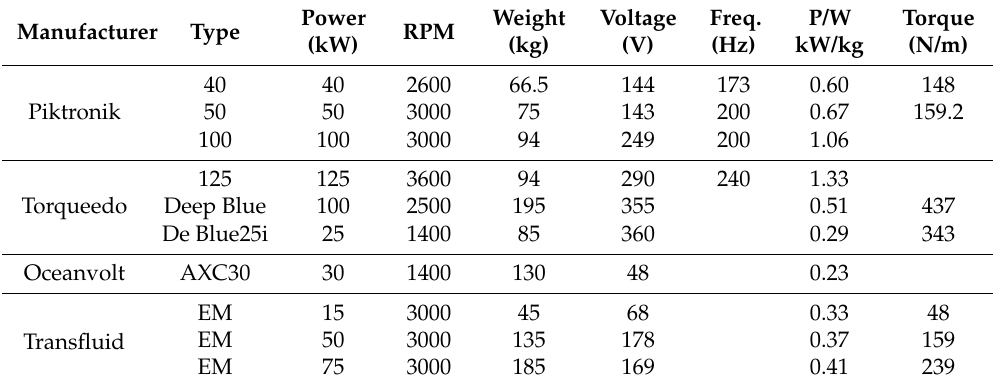
Table 3. Electric engines for small